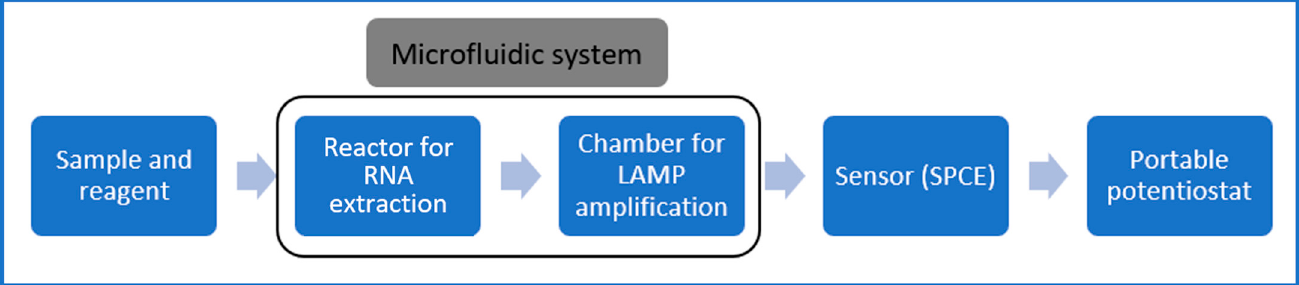
Figure 8. Microfluidic system in a portable electrochemical sensor for virus